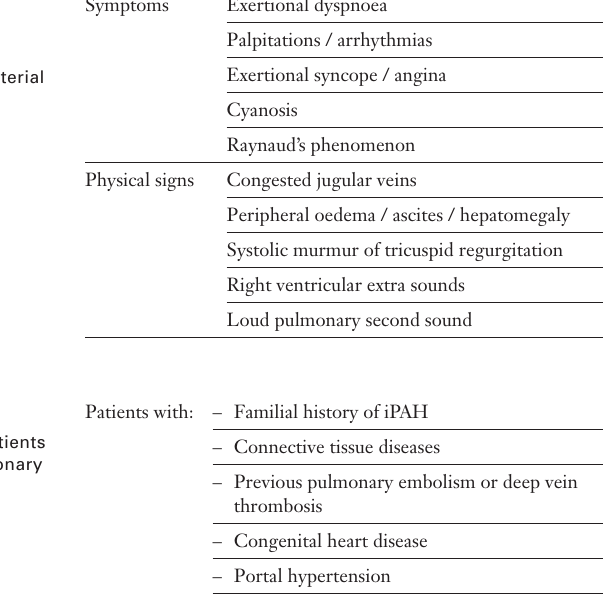
Physical signs and symptoms of pulmonary arterial hypertension.